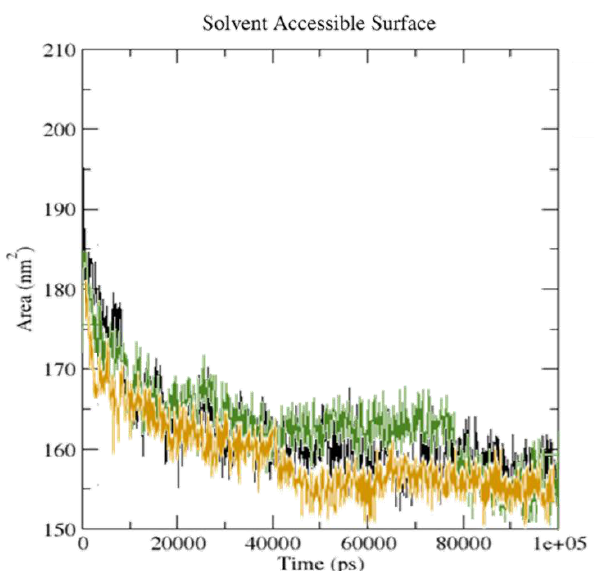
12 of 20 Figure 14. Average hydrogen bonding interactions between ( a ) [(FXN)(PA)] – serotonin and ( b ) (FXN) – serotonin at 100 ns simulation.